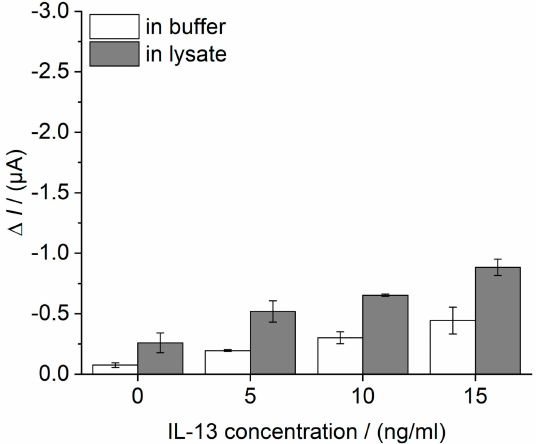
Figure 9. Evaluation of the selectivity of the IL-13 immunosensor. Cell lysate of human lung cancer cell line NCI-H1975, normalized to a total protein amount of 5 µ g and spiked with defined IL-13 concentrations (grey). For comparison, 0.1 M PBS pH 7.4 plus 1% (w/v) BSA was spiked with equal IL-13 concentrations (white). Immunosensors were prepared in triplicates. Amperometric measurements performed at 0.0 V and without temperature control, i.e., at room temperature. Measurements in flow cell with continuous flow of 1 mM hydroquinone in 0.1 M PBS pH 6 with 0.8 mL/min, injection flow of 1.5 mM hydrogen peroxide in 0.1 M PBS pH 6 with 0.4 mL/min and injection volume of 100 µ